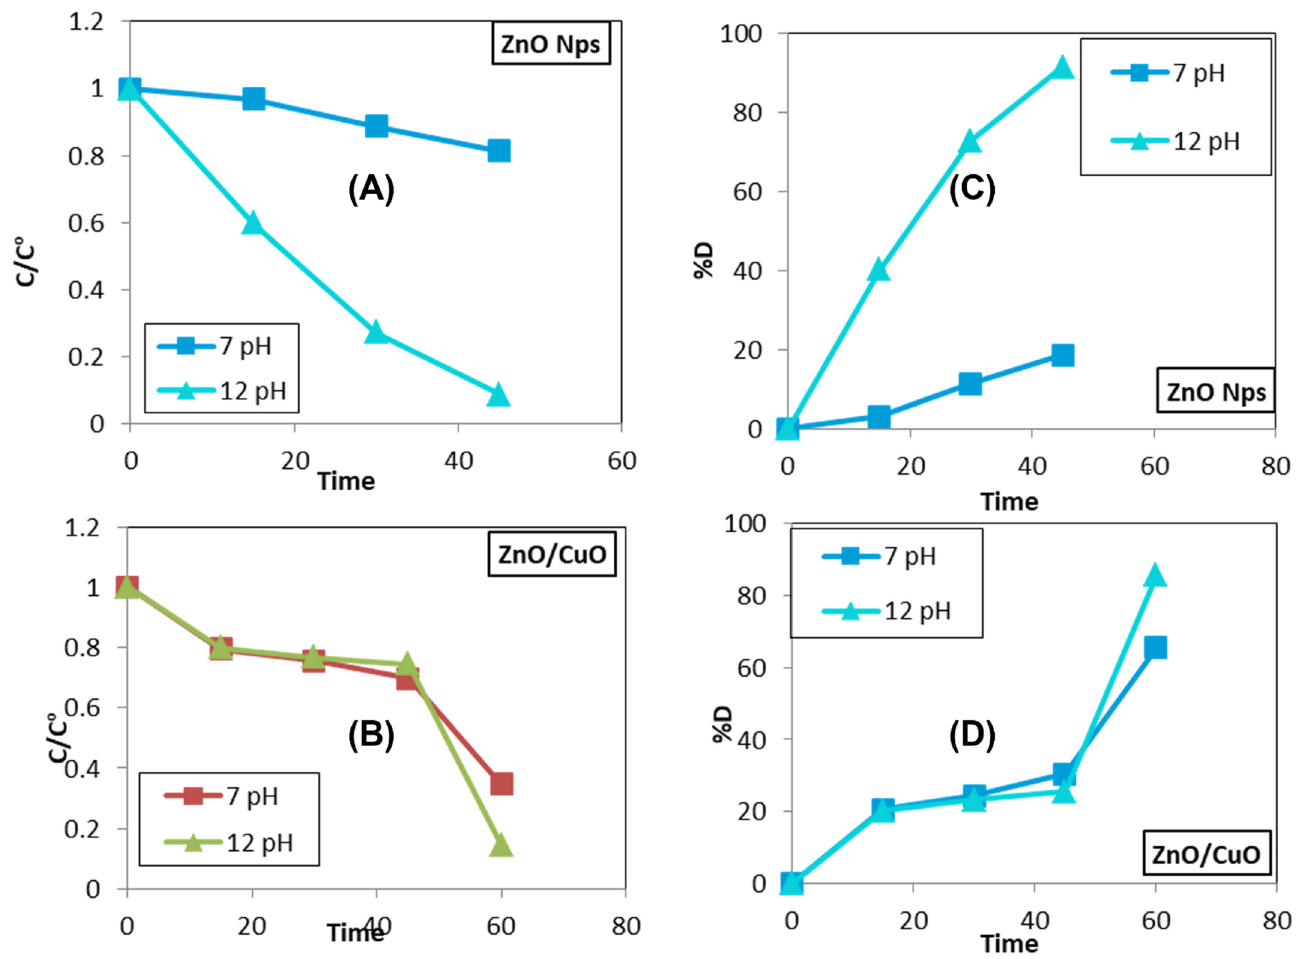
Figure 8. ( A , B ) C/Co of ZnO Nps and ZnO/CuO nanocomposite at pH 7 &12, and ( C , D ) % degra- dation of ZnO Nps and ZnO/CuO nanocomposite at pH 7